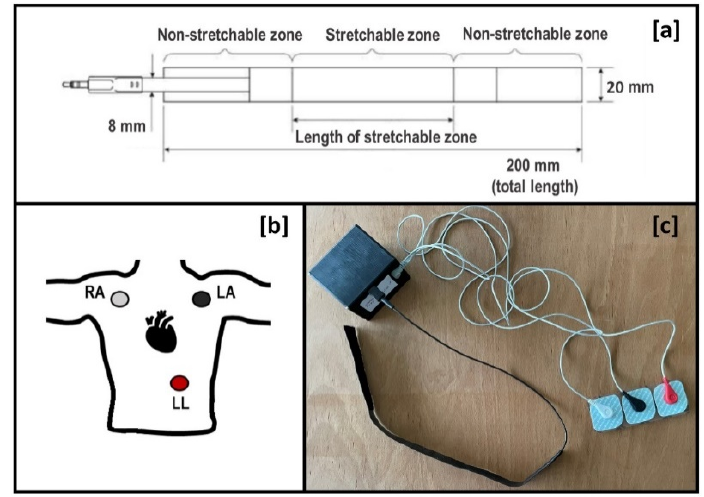
Figure 2. The plethysmography system: capacitive strain gauge sensor ( a ), electrode placement for 3-lead ECG ( b ), portable electronic unit ( c ).